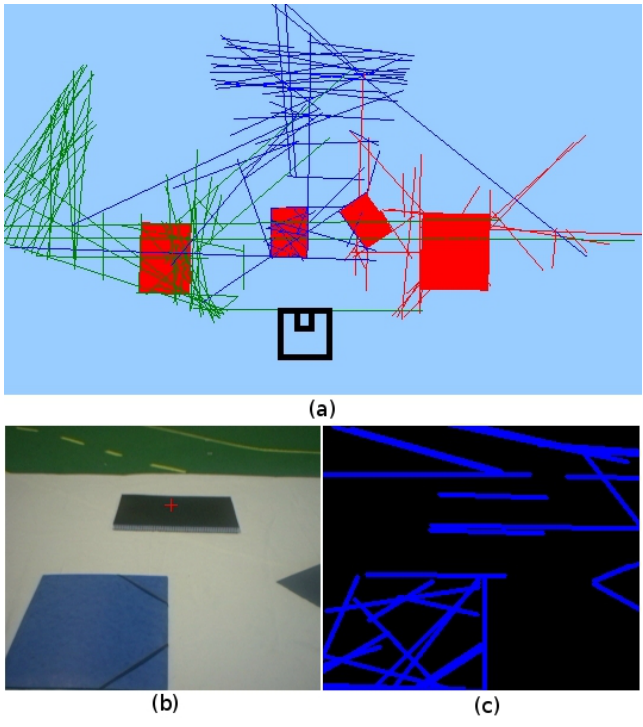
Figure 6. Complex primitives in visual memory: parallelograms with